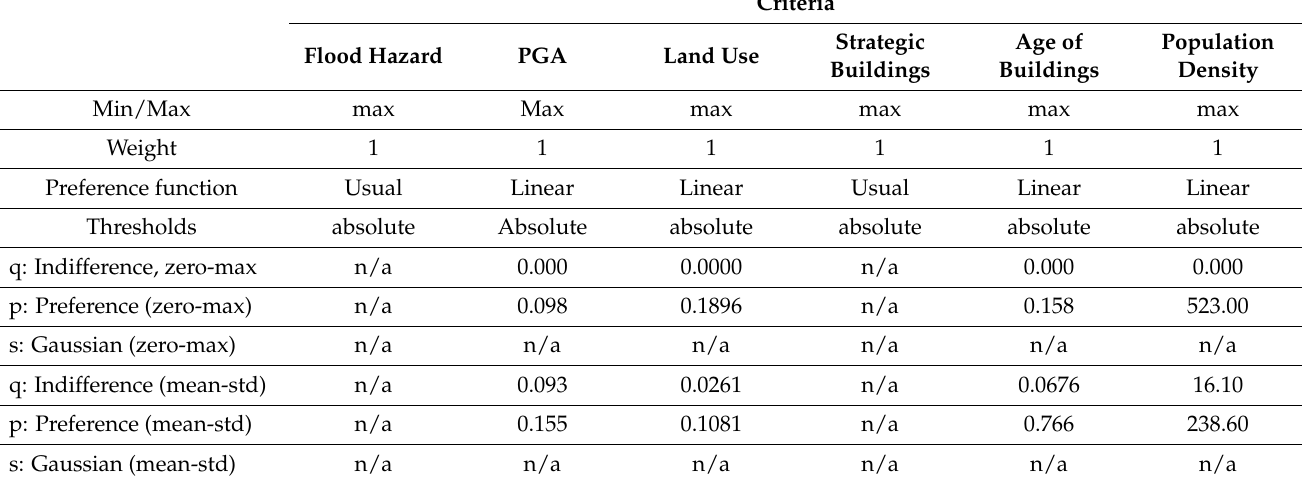
Table 2. Preference functions and the associated thresholds p , q , and s .